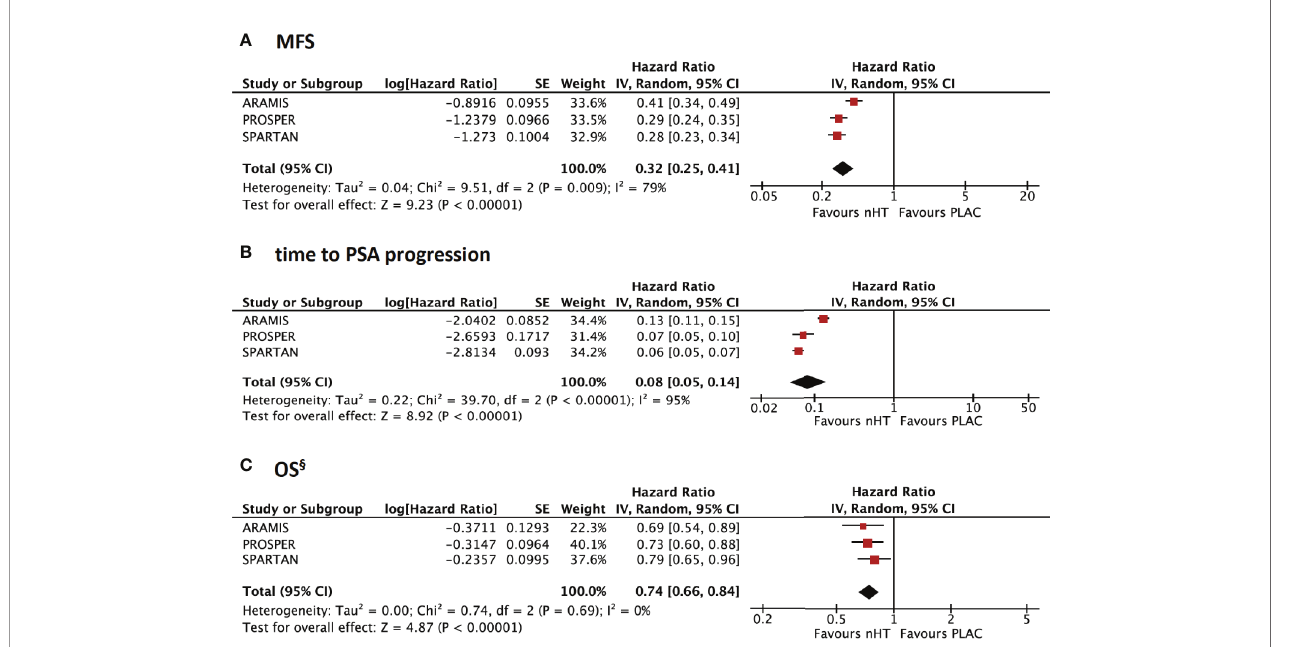
FIGURE 1 | Forest plots reporting pooled survival outcomes from the 3 included studies. (A) Metastasis-free survival (MFS); (A) time to Prostate-speci fi c antigen (PSA) progression; (C) overall survival (OS). § OS data are updated to fi nal analyses with mature OS data. [CI, con fi dence interval; nHT, novel hormonal therapy; PLAC, placebo].